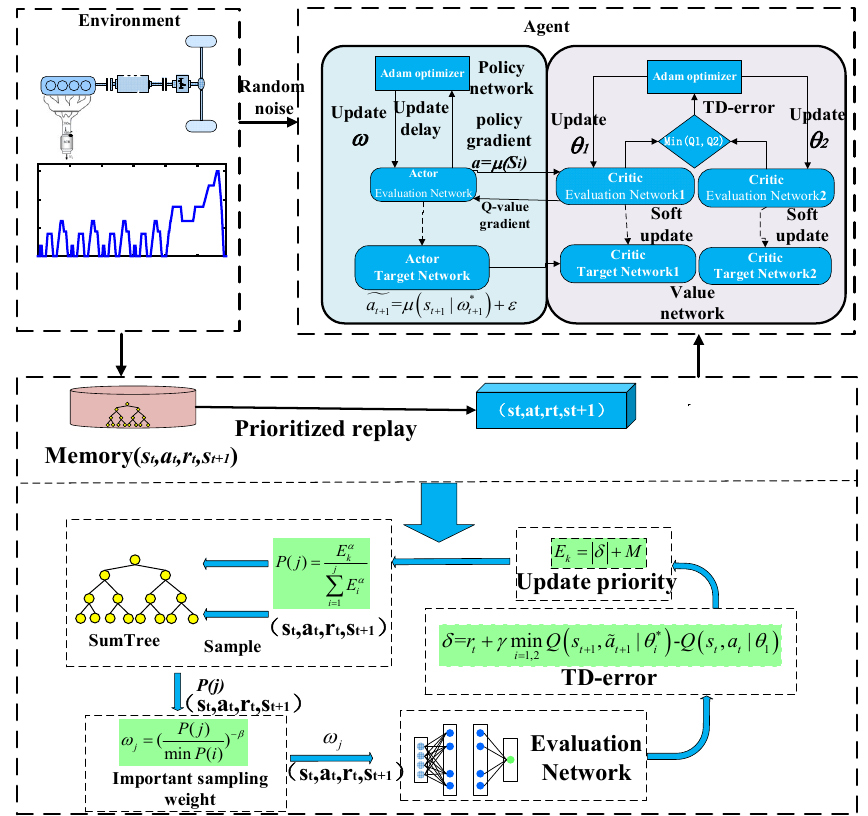
Figure 7 . Schematic of the control strategy based on PER ‐ TD3. Figure 7. Schematic of the control strategy based on